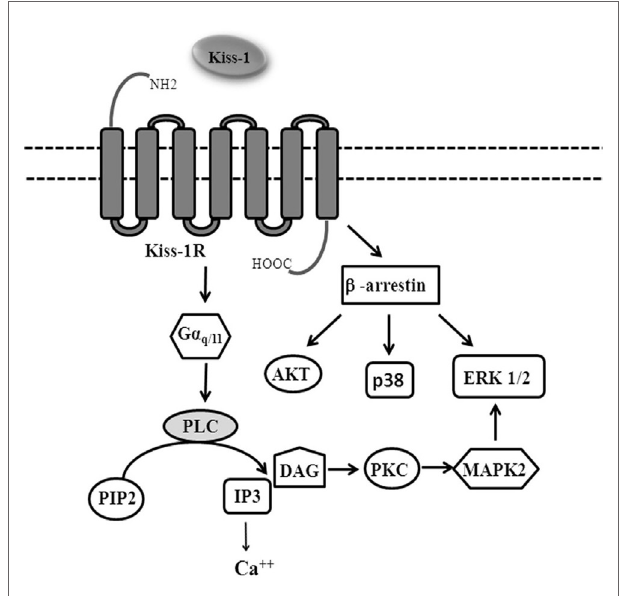
FigURe 1 | Signaling pathways activated by